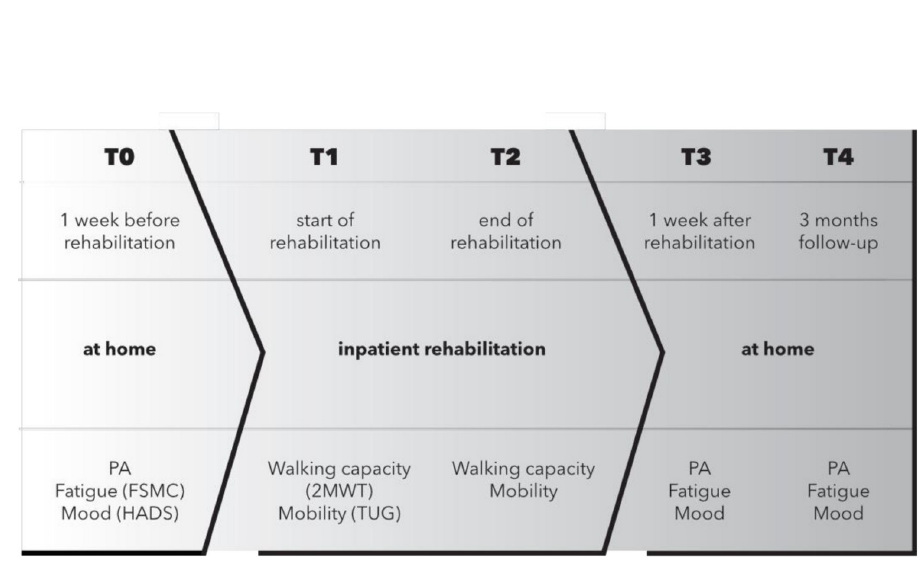
Fig 2. Time schedule of interventions and outcome measurements. Abbreviations: PA, physical activity; FSMC, Fatigue Scale for Motor and Cognitive functions; HADS, Hospital Anxiety and Depression; 2MWT, Two-Minute Walk Test; TUG, Timed Up and Go test; T0–4, time point for outcome measurements.